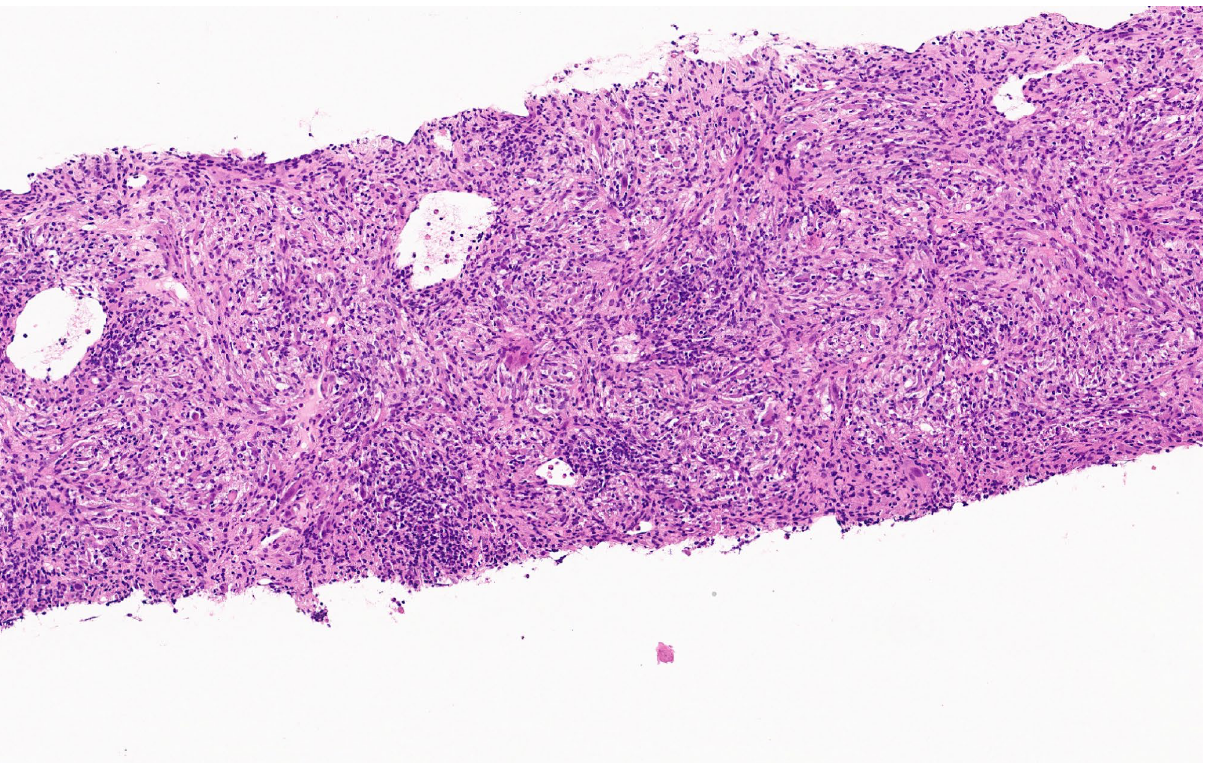
Fig. 1 MRI image of a solid mass involving segment VII of the right hepatic lobe ( a ). Hypermetabolic, hypodense, and homogeneous hepatic lesion (SUV max = 12,6) of demarcated boundaries ( b ). Comparative study of contrast-enhanced CT-scan every two months with a gradual reduction in size over time ( c, d , and e